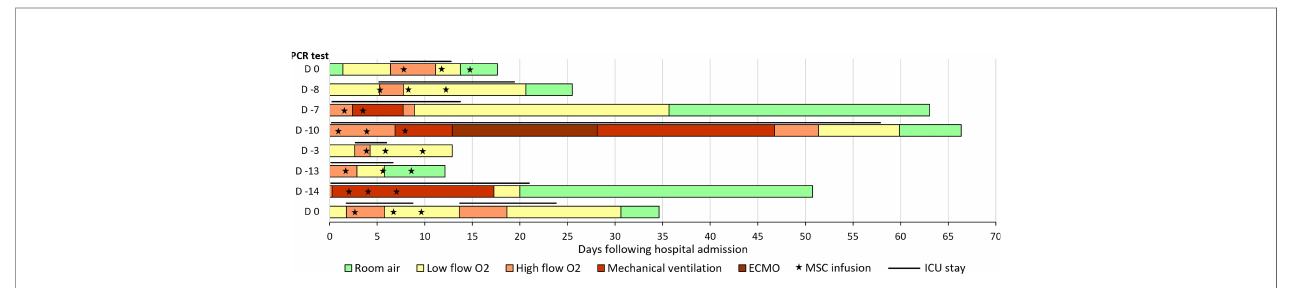
FIGURE 1 | Evolution of oxygen support in patients treated with BM-MSCs. The bars represent the length of hospitalization (in days), and the left column indicates the day of the fi rst positive PCR test, with day 0 being the day of hospital admission. The lines above the bars represent the length of ICU stay, and the “ star ” symbols represent MSC administrations. ECMO, extracorporeal membrane oxygenation; MSC, mesenchymal stromal cells; ICU, intensive care unit.